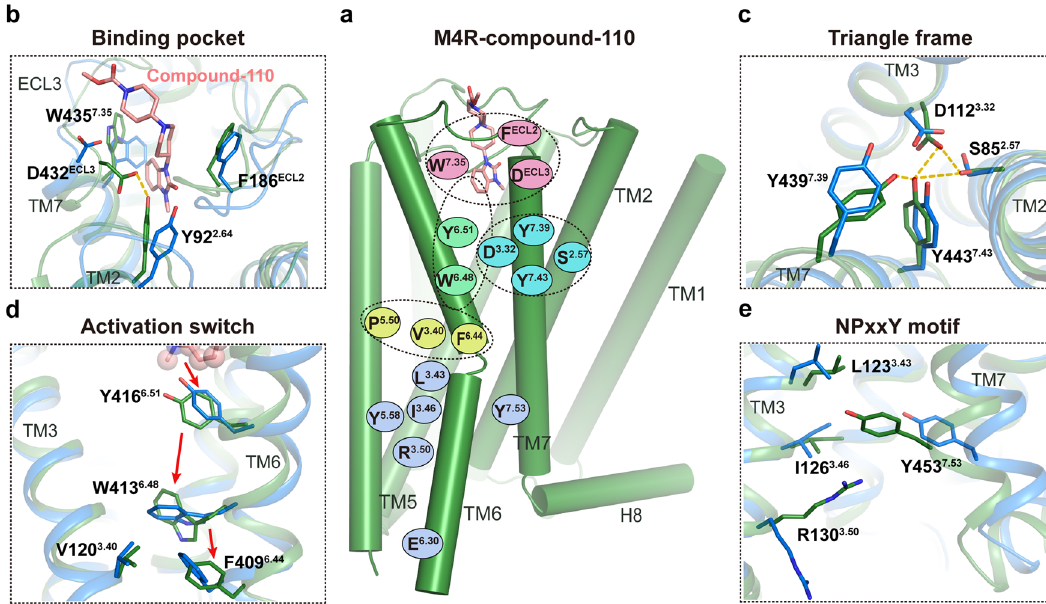
Fig. 4 The unconventional activation mechanism of compound-110. a Schematic summarizing the key translational and rotational movements contributing to M4R activation induced by compound-110. b Extracellular conformational changes from inactive (blue) to compound-110-bound active (green) M4R. c A speci fi c ‘ triangle frame ’ formed by the side chains of residues Asp112 3.32 , Ser85 2.57 , and Tyr443 7.43 in the M4R – c110 – G i structure. d Conformational changes of residues Tyr416 6.51 and Trp413 6.48 during M4R activation by compound-110. e Conformational changes of the NPxxY motif between inactive and compound-110-bound active M4R structures.